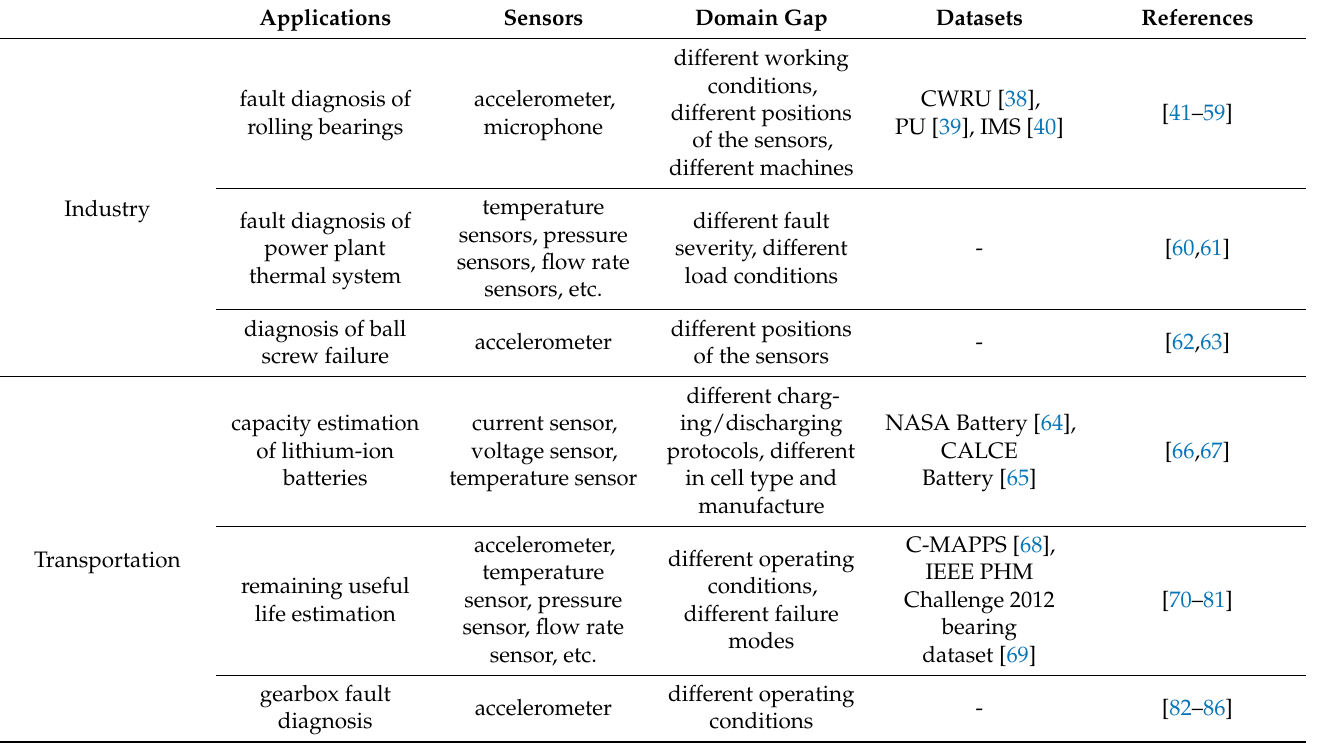
Table 1. Classification results based on different